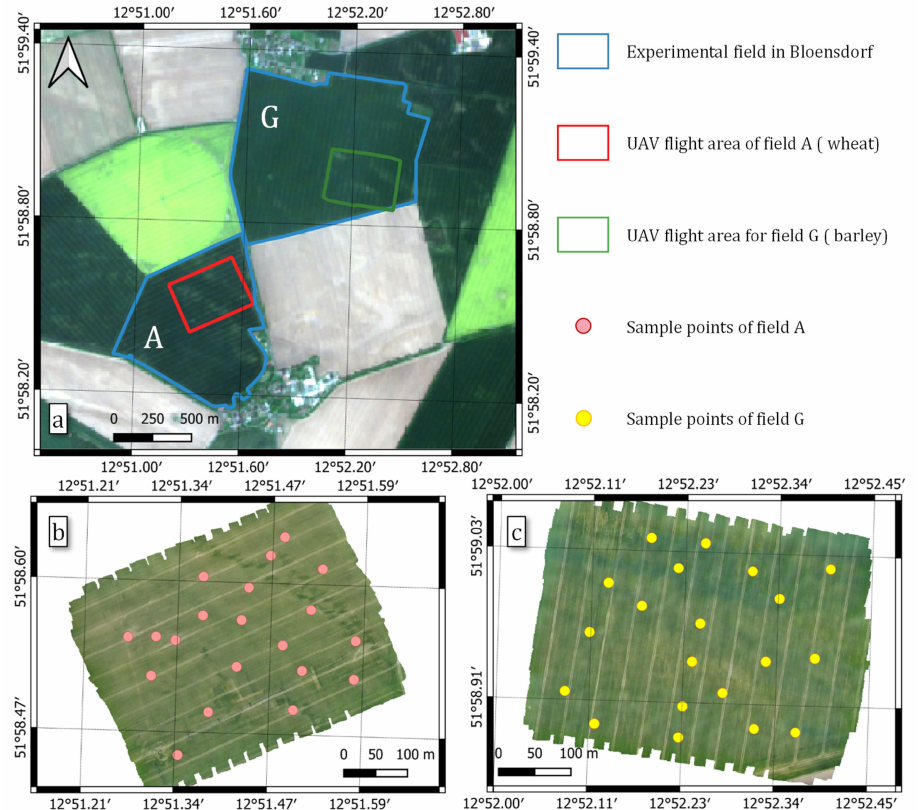
Figure 1. The layout of the study site and the distributions of the flight areas. The ( a ) study site was marked as blue line. The UAV flight area for field A was marked as red line ( b ). The UAV flight area for field G was marked as green line ( c ). The sampling locations of canopy height, LAI, leaf nitrogen were marked as pink dots (field A) and yellow dots (field G). The main soil type is eolian sediments and glacial sediments, and the soil texture varies between sandy, silty loam, and weak loamy